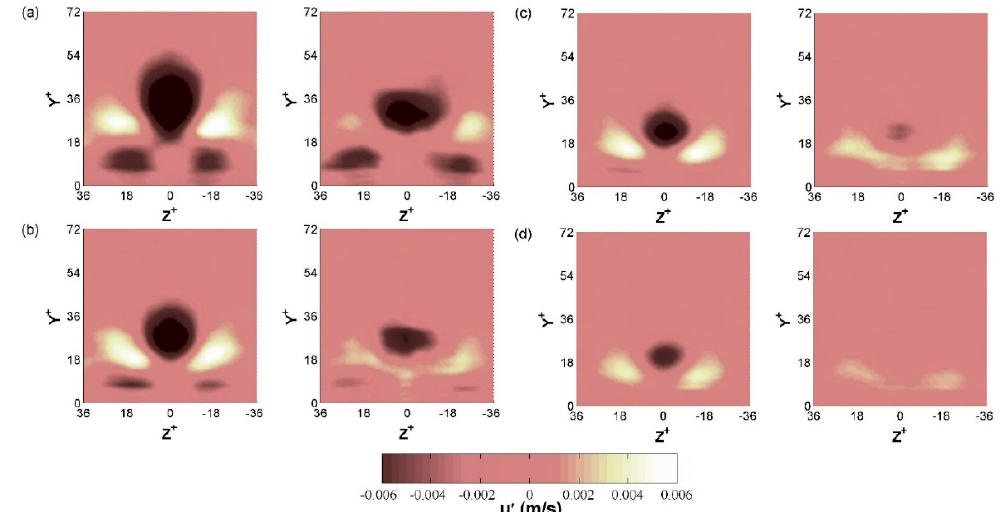
Figure 8. Phase-locked averaged velocity fluctuations of the YZ plane at x = 4.4 δ , as indicated by the dotted line in the last figure of Figure 7. Induced high (white) and low (black) momentum towards near-wall: ( a , b ) by vorticity of neck part; ( c , d ) by vorticity of leg part.